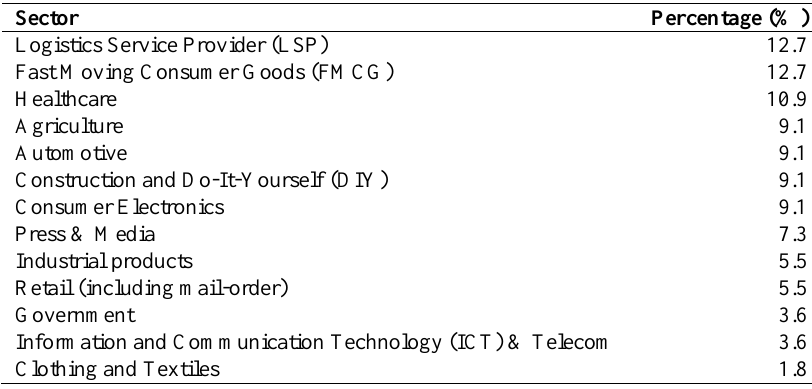
Table 1. Response percentages per